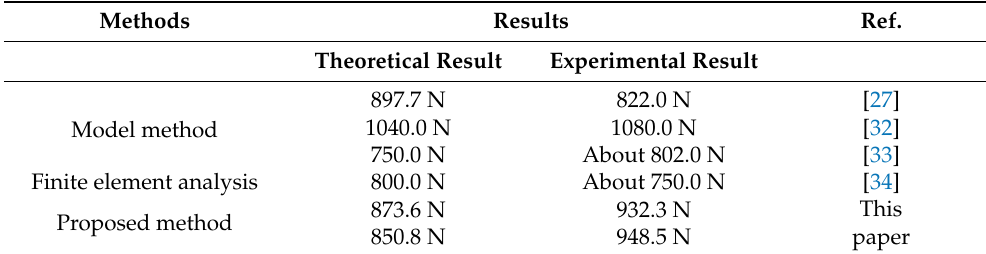
Table 2. Comparison between different methods for predicting the forming force. Methods Results